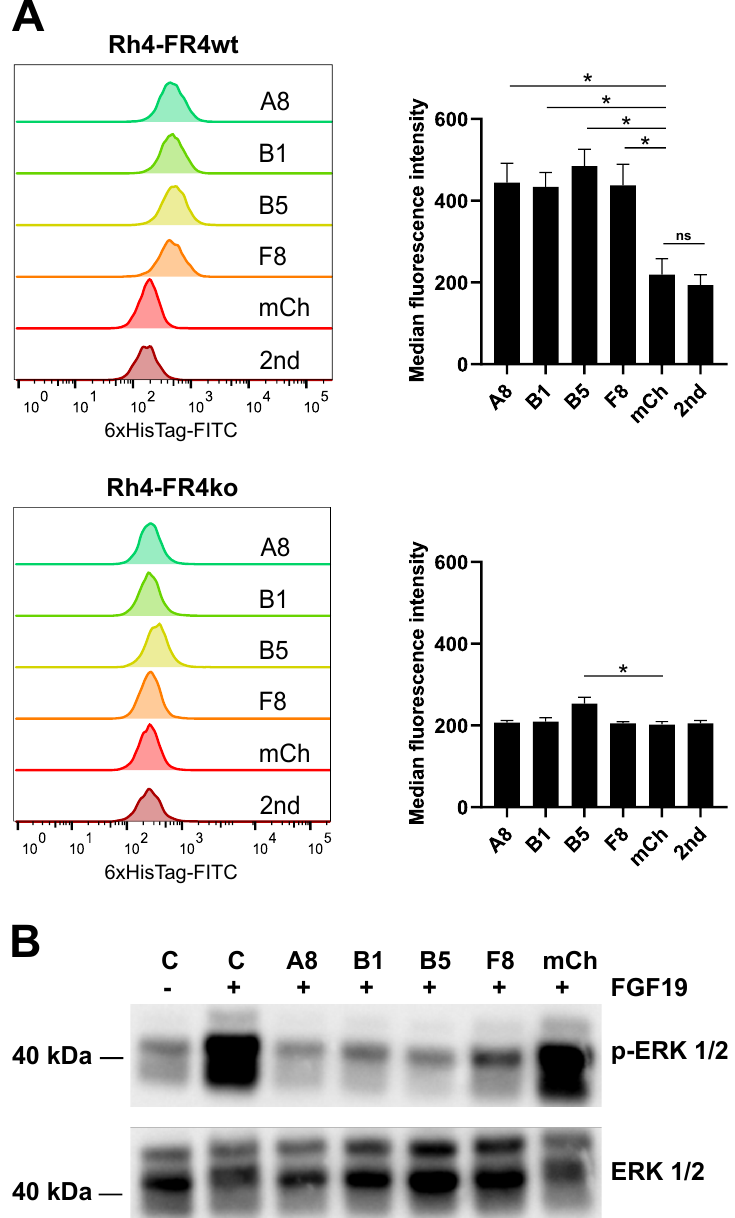
Figure 2. In vitro binding validation of sdAb. ( A ) SdAb were tested for their binding selectivity to cell surface FGFR4 by flow cytometry. Histograms show the single-cell living population of each sdAb binding to Rh4-FR4wt versus Rh4-FR4ko cells. Secondary FITC-labeled anti-6xHis-tag antibody alone (2nd) was used as background control and mCherry (mCh) was used as negative control. Median fluorescence intensities (MFI) were determined with FlowJoTM10 software. Statistics: paired t-test, n = 3 independent experiments, mean + SD, * p ≤ 0.05, ns = not significant. ( B ) Activation assay of FGFR4 in Rh30 cells was performed with recombinant FGF19 and in combination with sdAb. The cells were incubated for 1 h with sdAb at 10 µ M (A8, B1, B5, F8, mCh) followed by stimulation of FGFR4 with 50 nM FGF19 for 10 min. Control cells were either not stimulated or stimulated with FGF19 in absence of the sdAb. The cell lysates were analyzed by Western blot with anti-phospho-ERK1 / 2 antibody. Total Erk1 / 2 levels are shown as loading control. The complete pictures of the Western blots can be found in Figure